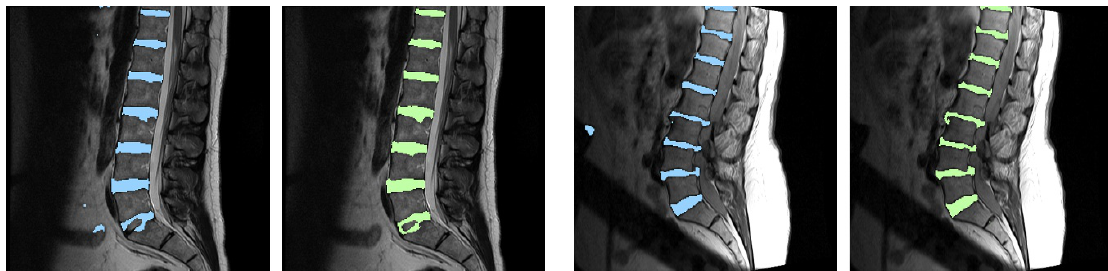
Figure 10. Comparison between dilated U-net and BSU-net. Blue area denotes segmentation results of dilated U-net and green area denotes segmentation results of BSU-net.